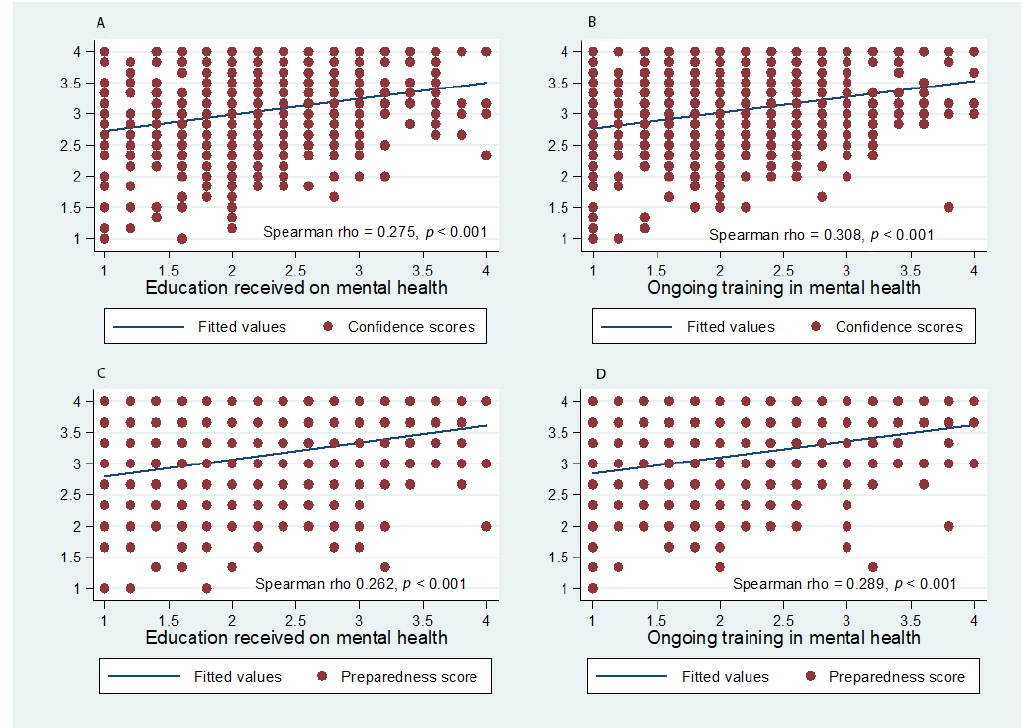
Figure 1. ( A – D ) Confidence and preparedness scores by received and ongoing education on and training in mental health.